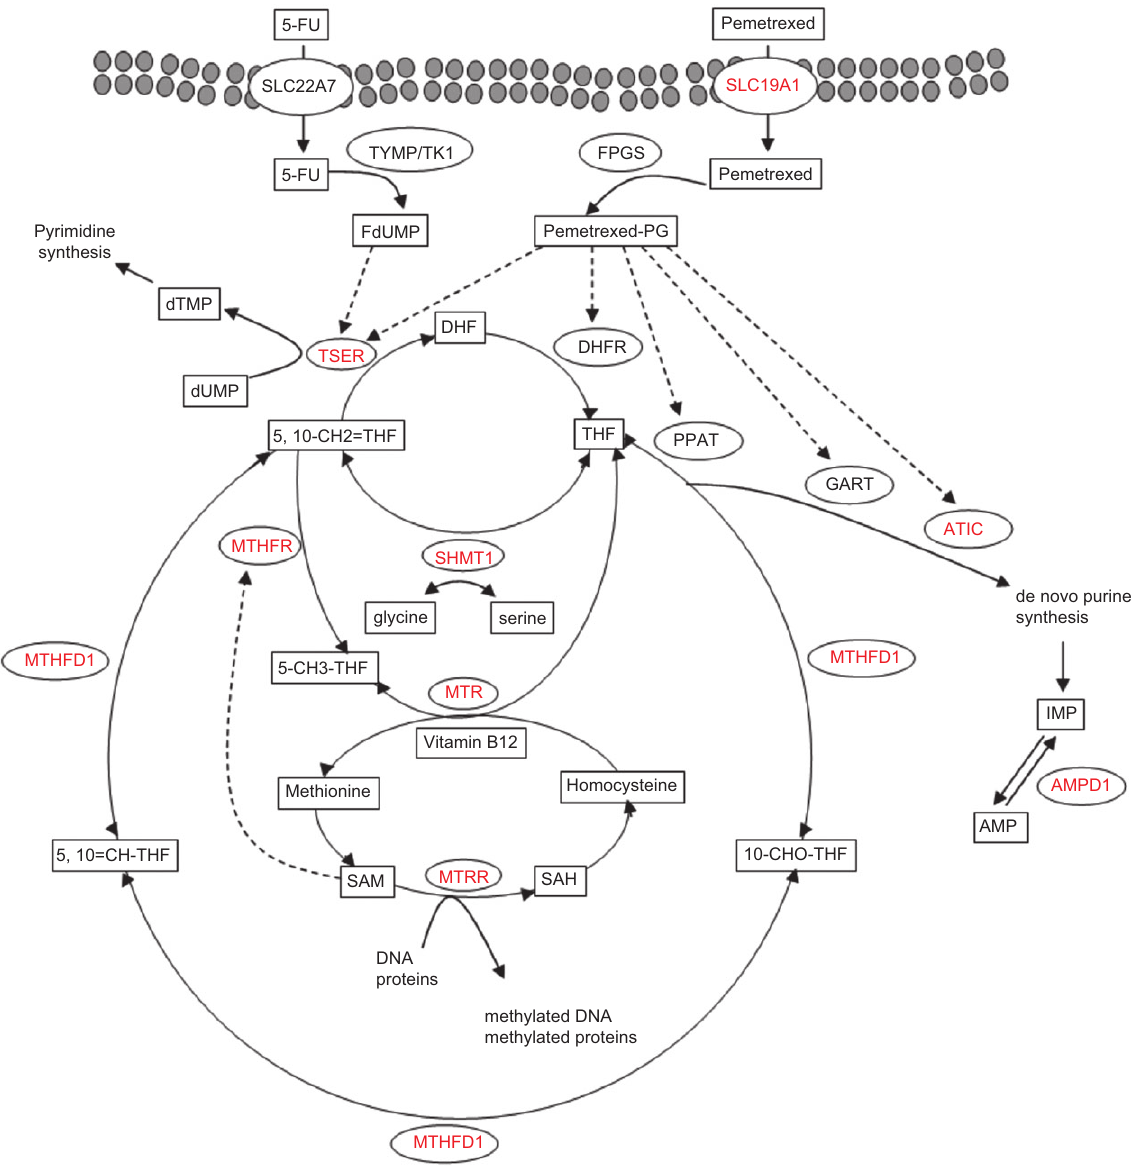
Figure 1 Scheme showing proteins involved in Pemetrexed and 5FU activity. All the enzymes encoded by the candidate genes/polymor- phisms assessed in this study are marked in red. Pemetrexed is transported into the cells through SLC19A1 and is metabolized by FPGS to its active metabolite. Pemetrexed polyglutamate forms inhibit TS, DHFR, GARFT, ATIC and MTHFD1L, fundamental for the de novo biosynthe- sis of thymidine and purine nucleotides. See for further explanation the